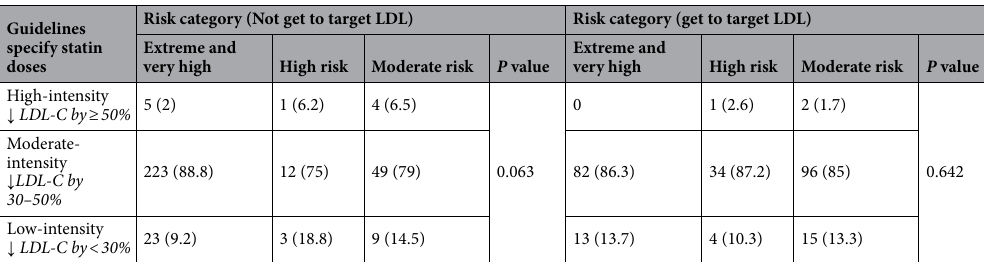
Risk category (Not get to target LDL) Risk category (get to target LDL) Guidelines specify statin Extreme and doses very high High risk Moderate risk P value High-intensity ↓ LDL-C by ≥ 50% 5 (2) 1 (6.2) 0.642Moderate- intensity ↓ LDL-C by 30–50% Low-intensity ↓ LDL-C by < 30% 23 Table 7. Comparison of statin patterns use and proportion of different CVD risk group in patients who get to target LDL and not achieved. Statin derivation therapy in three groups; low, moderate, or high intensity. High- intensity statins usually reduce LDL-C levels by 50% whereas moderate and low intensity statins groups reduce LDL-C by 30–49% and less than 30%, respectively.